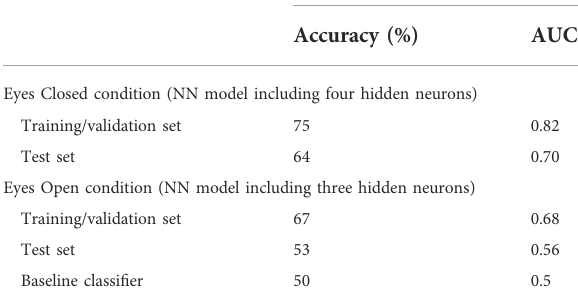
TABLE 6 Performance of the NN model when addressing the classi fi cation problem in the Eyes Closed condition (upper part) and the Eyes Open condition (lower part). Results are reported separately for the training/validation set and the test set, together with the performance of the baseline model (random classi fi